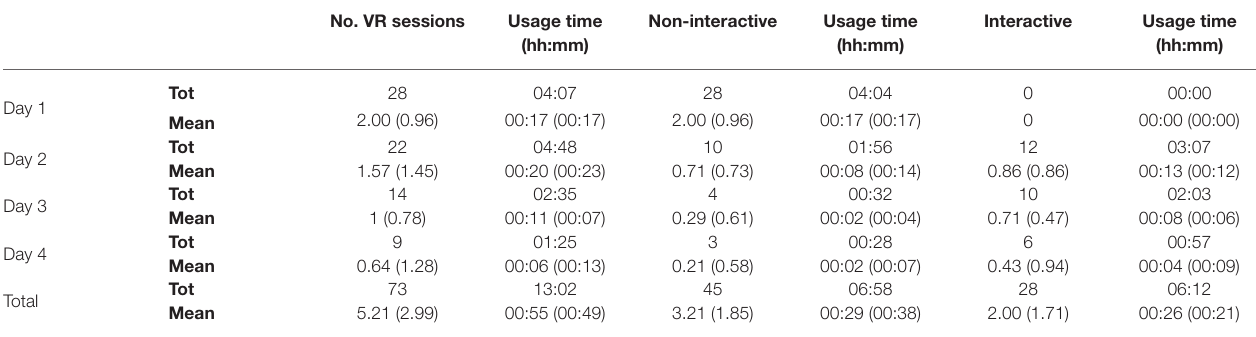
TABLE 2 | Usage time of VR use from all participants.